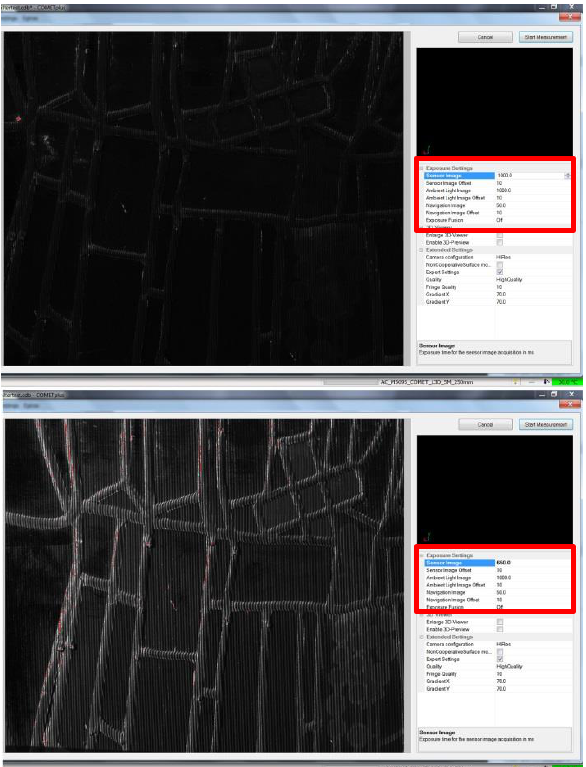
Figure 2. Oswiecim 2b ; Comparison of different light setups, within the scanner software, with and without the use of polarising filters. Upper part: Setup with filter; highest possible light settings don’t provide enough light for scanning. Lower part: without filter, but scanner located 70° to surface; ideal light